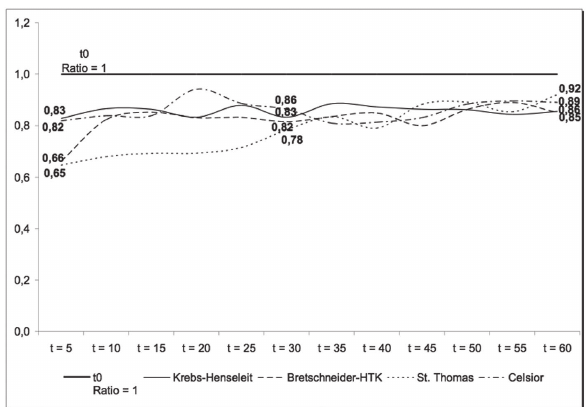
Fig. 1 - Heart rate (HR), according to the solution. Reperfused hearts were monitored for 60 min after treatment with the following solutions: Krebs-Henseleit Buffer, Bretschneider-HTK, St. Thomas No. 1, and Celsior. Baseline was calculated after stabilization and prior to